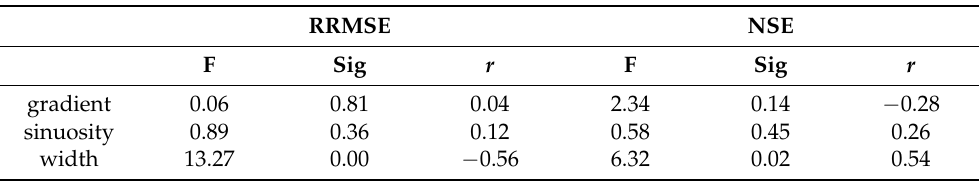
Figure 7. Surface water dynamics of river sections in study regions. ( a , c , e , g ) are the water occurrence (the darker the color of water occurrence map, the easier it is to be extracted stably). ( b , d , f , h ) are the maximum water extent. (Gauge Qilian and Gauge Zhamashike are not shown due to data availability). Table 4. F statistics and Sig values of the multivariate analysis of variance, and correlation coefficient (r) between RRMSE/NSE and river morphological